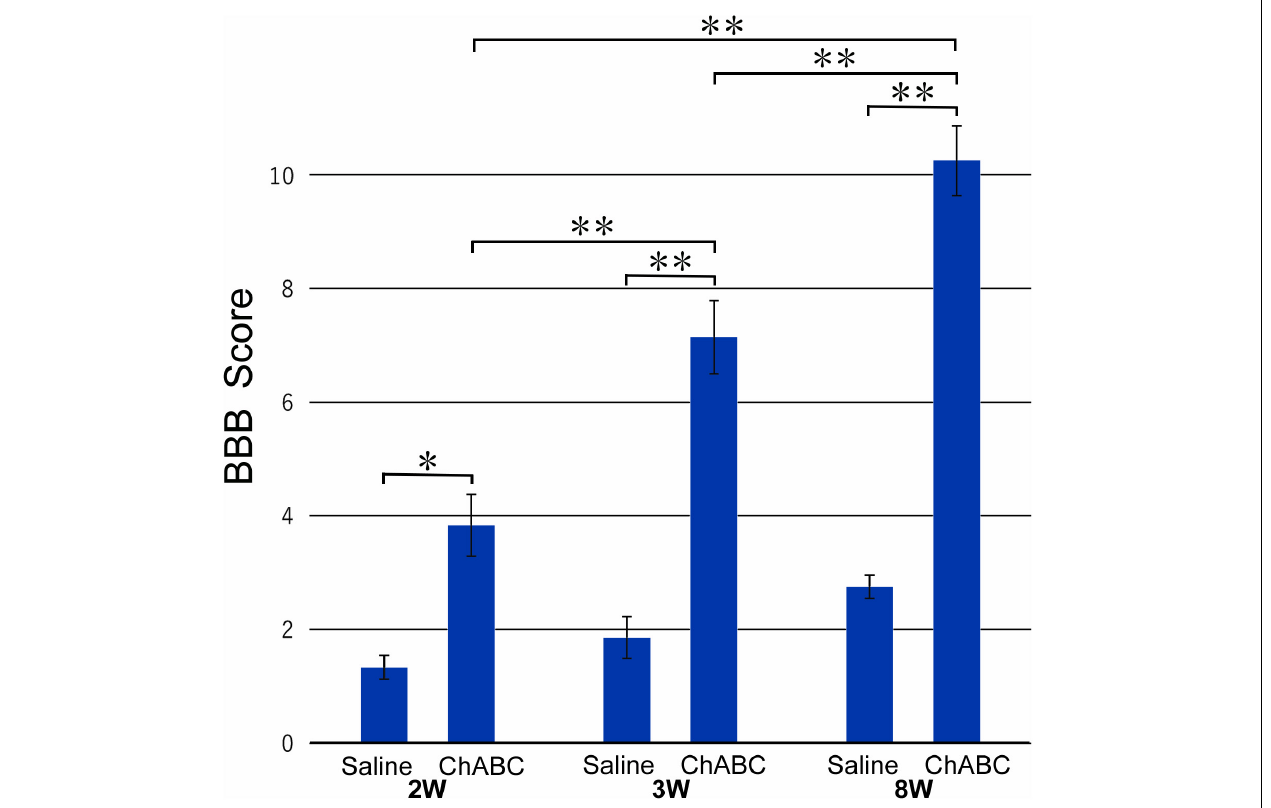
FIGURE 1 | The Basso, Beattie, and Bresnahan (BBB) score of rats with ChABC or saline administration at 2, 3, and 8 weeks after complete spinal cord transection (CST). Significant differences are indicated by ∗∗ p < 0.01 or ∗ p < 0.05.